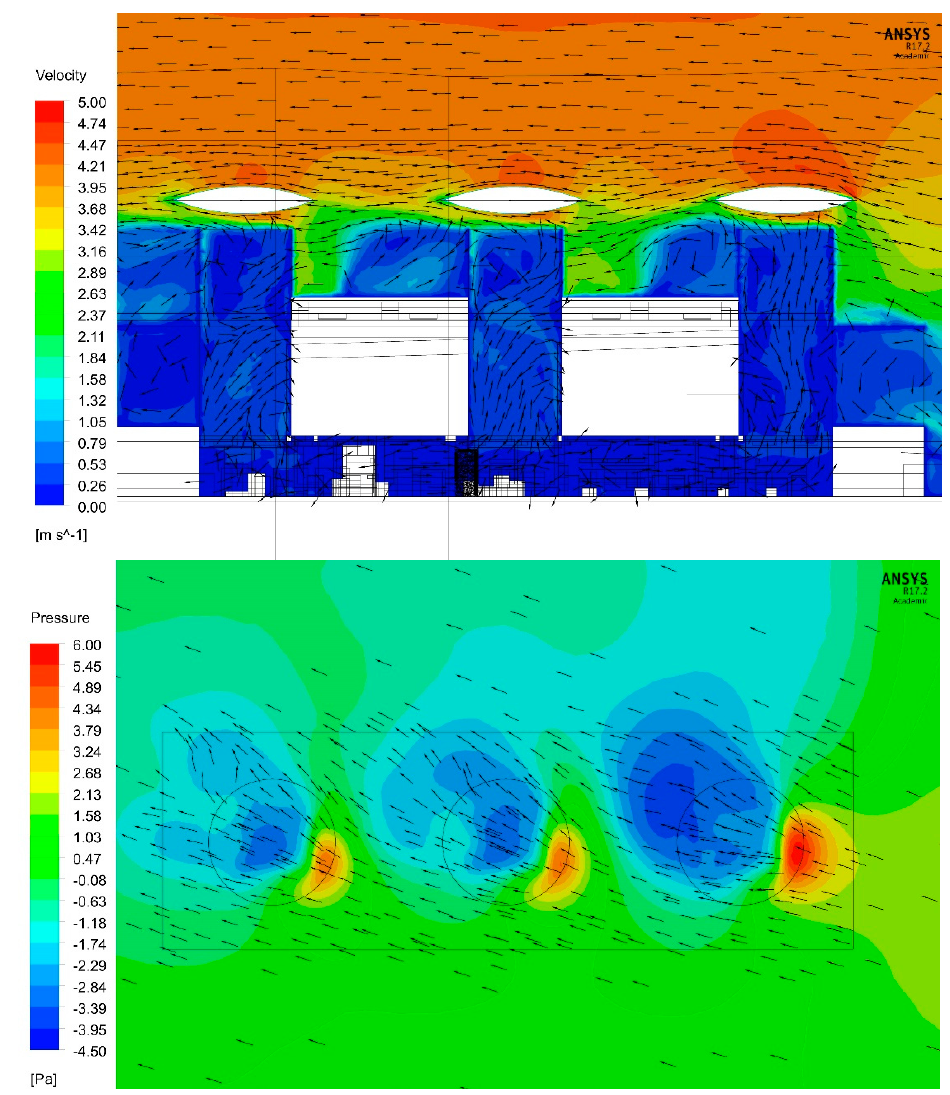
Figure 17. Longitudinal section through the hall with flow velocities (top) and pressure field at the ‘Venturi’ plates (bottom).